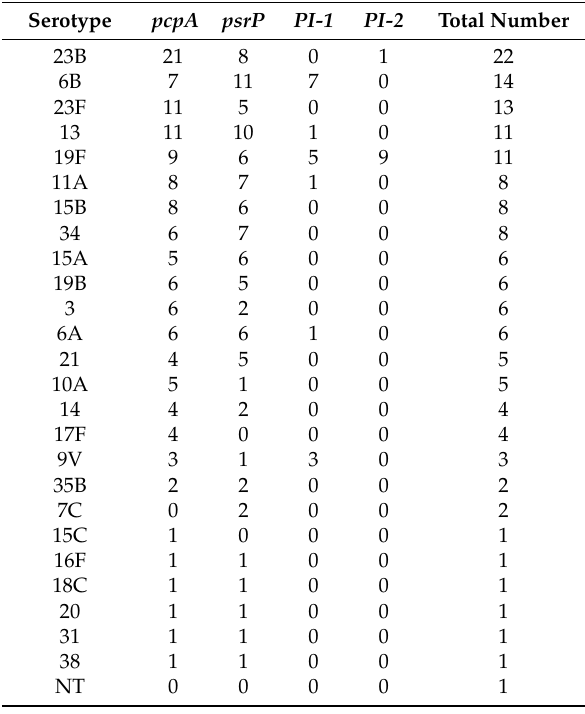
Table 3. Distribution of virulence genes among the di ff erent